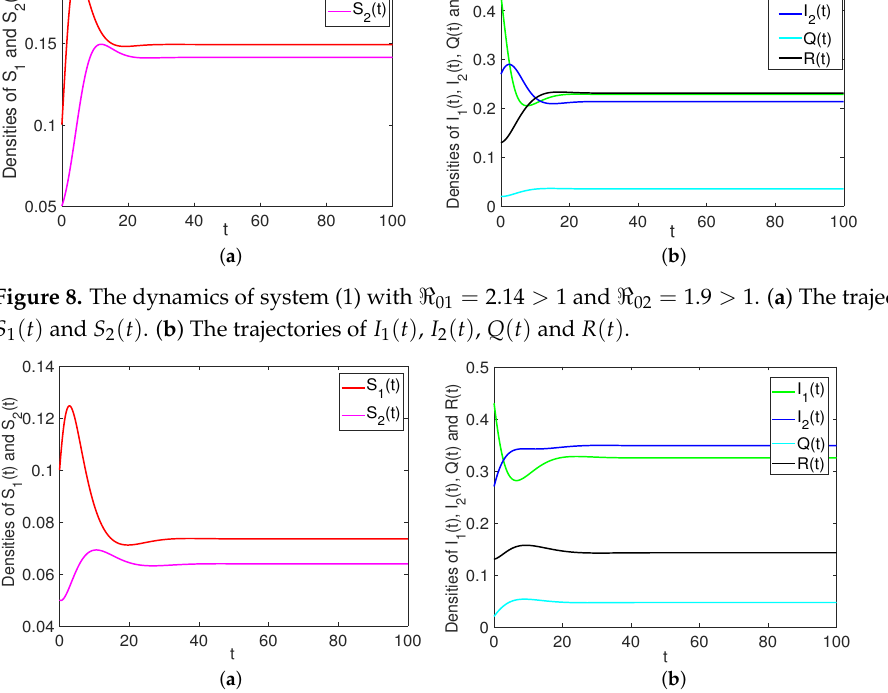
Figure 9. The dynamics of system (1) with (cid:60) 01 = 1.48 > 1 and (cid:60) 02 = 1. ( a ) The trajectories of S 1 ( t ) and S 2 ( t ) . ( b ) The trajectories of I 1 ( t ) , I 2 ( t ) , Q ( t ) and R ( t ) .